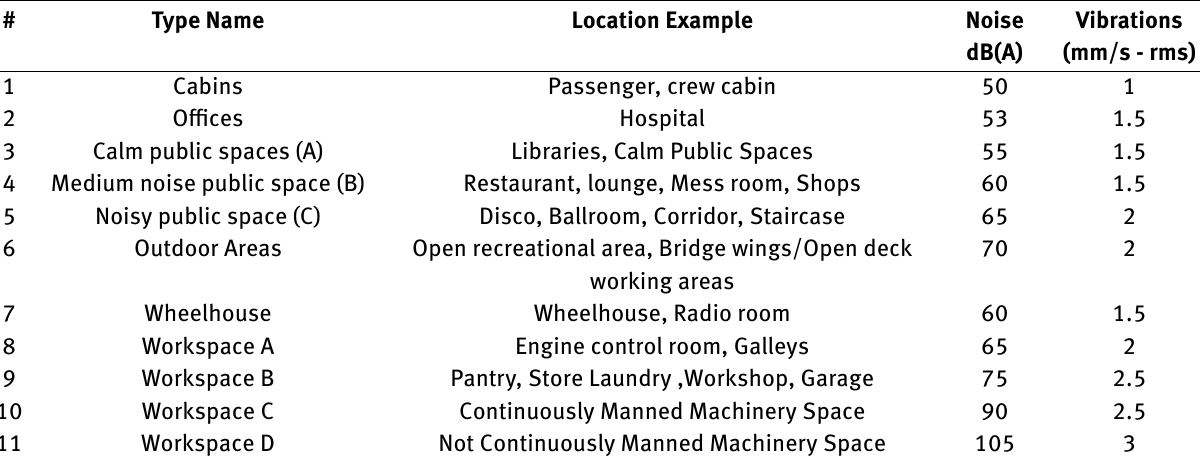
Table 1: Pre-normative SILENV N&V limits (Green